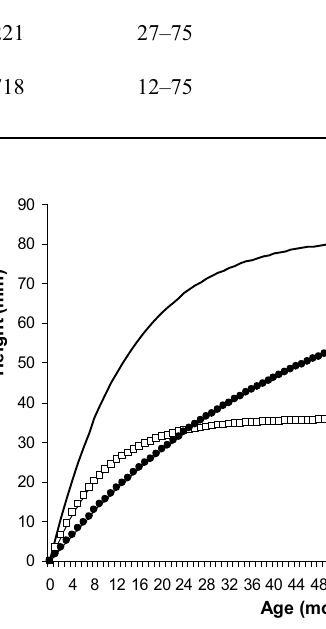
Fig. 2. Height at age growth curves of small-sized group, large-sized group and both groups of freshwater E. elliptica oysters combined.